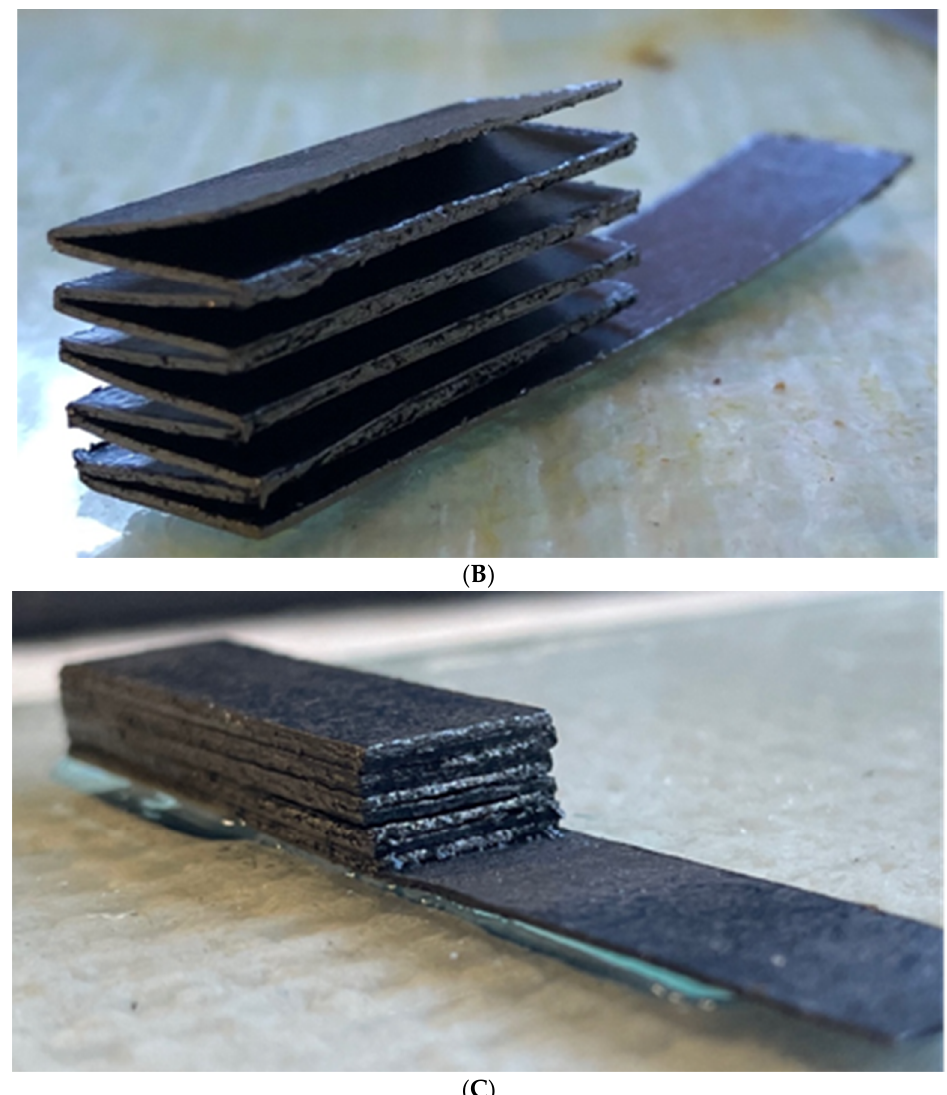
Figure 2. Accordion Electrode Structure : ( A ) Dimensions shown. For each electrode, a section of Grafoil, 10 cm × 3 cm + a tab at one end, was cut, scored, and folded as shown. ( B ) After initial folding, ~0.01 cm 3 of 3% NaCl/DI electrolyte was added to each ‘valley’. ( C ) The completed electrode.